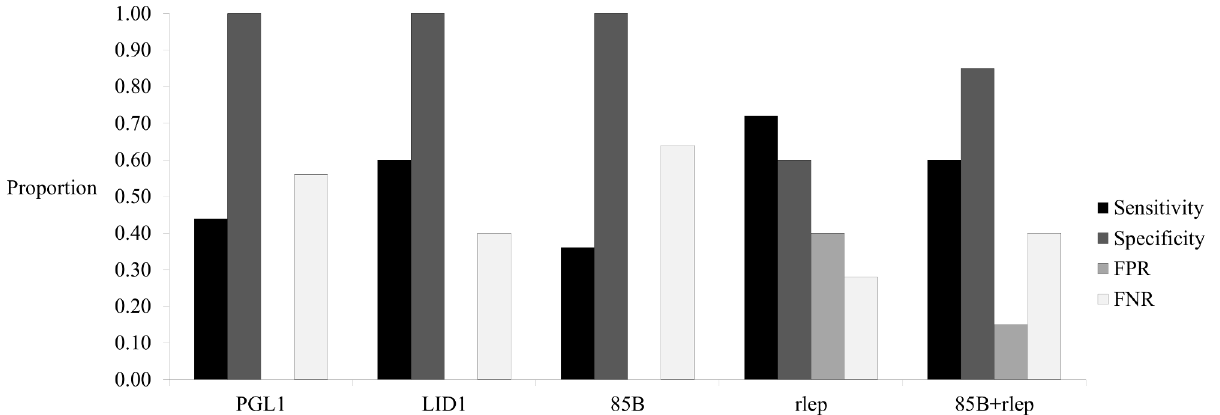
Fig 2. Sensitivity, specificity, false positive rate, and false negative rate determined in trial study. Analysis of the sensitivity (proportion of infected armadillos accurately identified as infected), specificity (proportion of non-infected armadillos identified as not infected), false positive rates (FPR, proportion of non-infected armadillos inaccurately identified as infected), and false negative rates (FNR, proportion of infected armadillos inaccurately identified as not infected) of ELISAs using blood samples and qPCRs using cheek swab samples. Assay types include the PGL1 ELISA (sensitivity = 0.44, specificity = 1.00, FPR = 0.00, FNR = 0.56), LID1 ELISA (sensitivity = 0.60, specificity = 1.00, FPR = 0.00, FNR = 0.40), 85B qPCR (sensitivity = 0.36, specificity = 1.00, FPR = 0.00, FNR = 0.60), rlep qPCR (sensitivity = 0.72, specificity = 0.60, FPR = 0.40, FNR = 0.28), and combination of 85B and rlep qPCRs (85B+rlep, sensitivity = 0.60, specificity = 0.85, FPR = 0.15, FNR = 0.40).